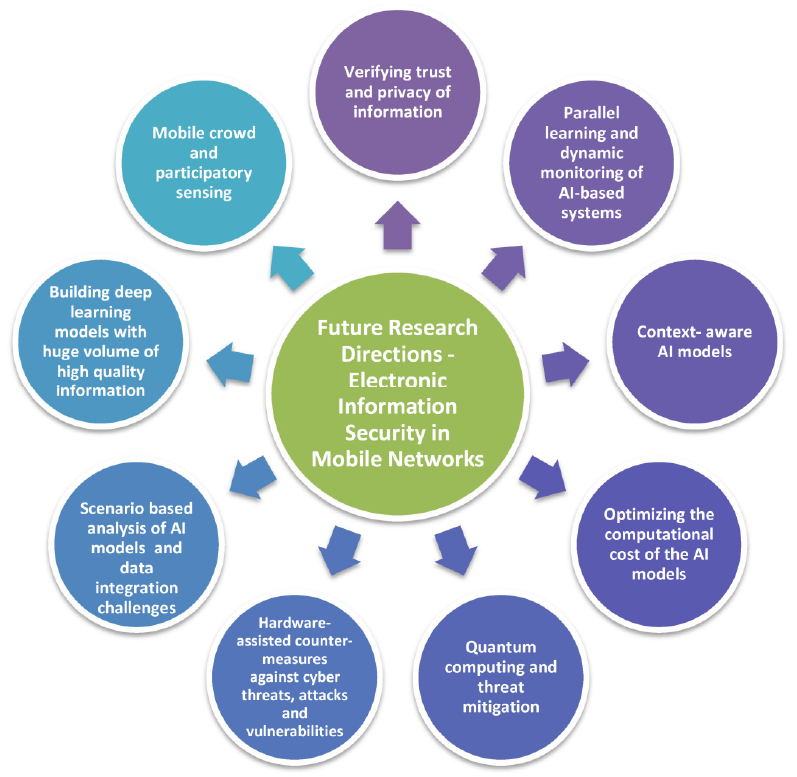
Figure 11. Future research directions—electronic information security in mobile networks.